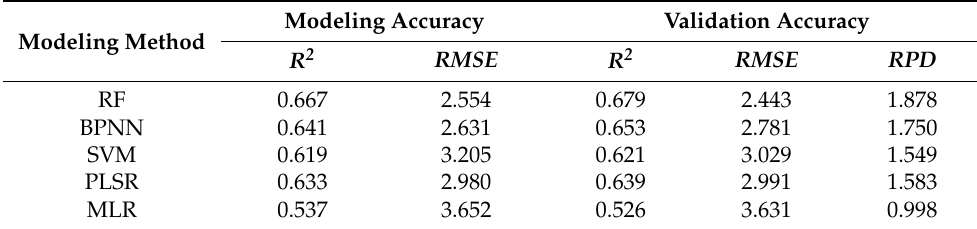
Table 9. Accuracy statistical results of SRSI retrieval model.